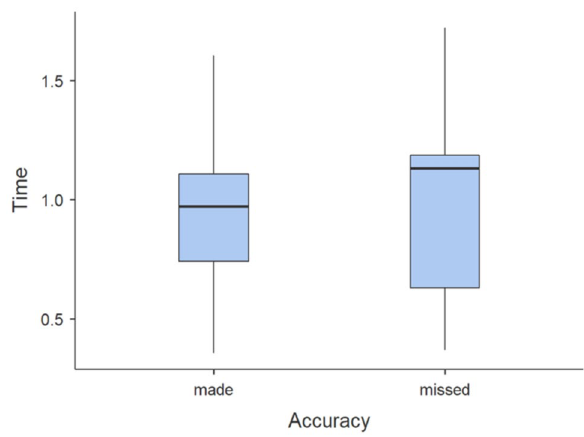
Figure 2. Time of free throw made and missed.